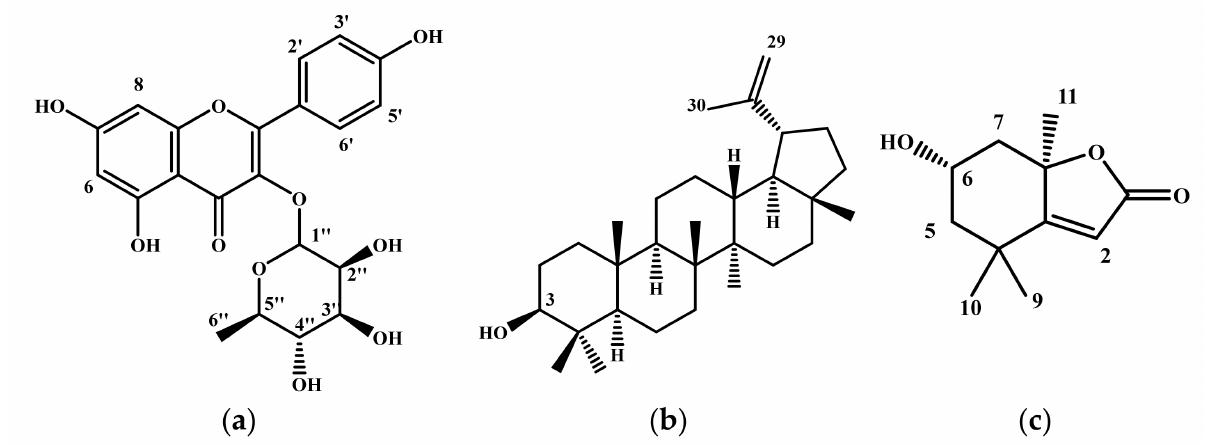
Figure 4. The general structures of molecules isolated and identified in EAE; ( a ) Structure of flavonol glycosides, ( b ) Structure of lupeol, and ( c ) Structure of